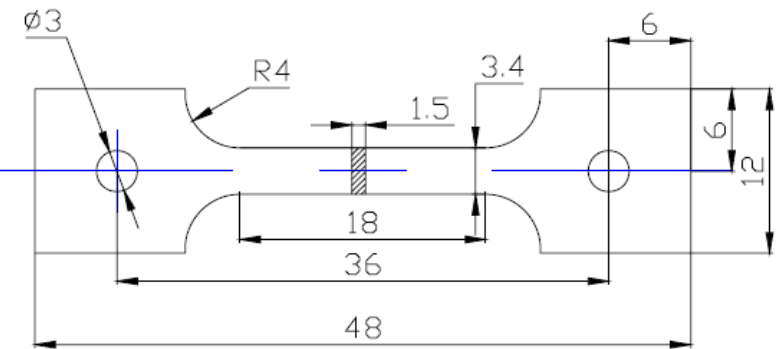
Figure 3. Dimensions of tensile testing sample (in mm, reproduced or adapted from [23], with permission from Elsevier, 2014).